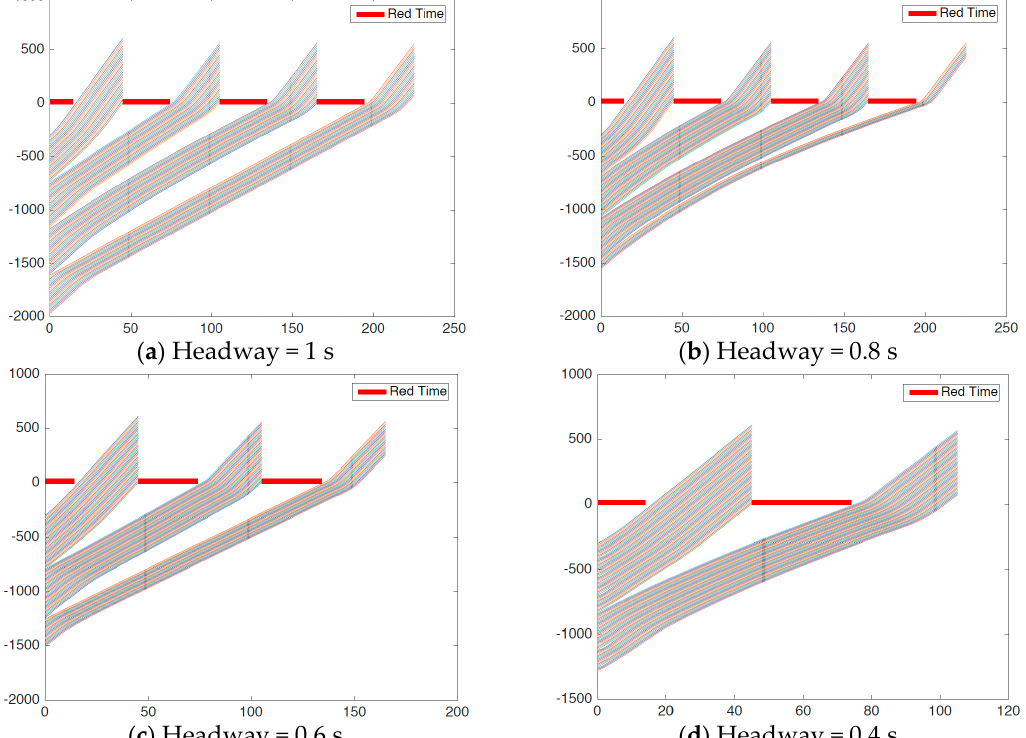
Figure 3. Optimal CAV trajectories for the proposed control algorithm under different initial following headways.